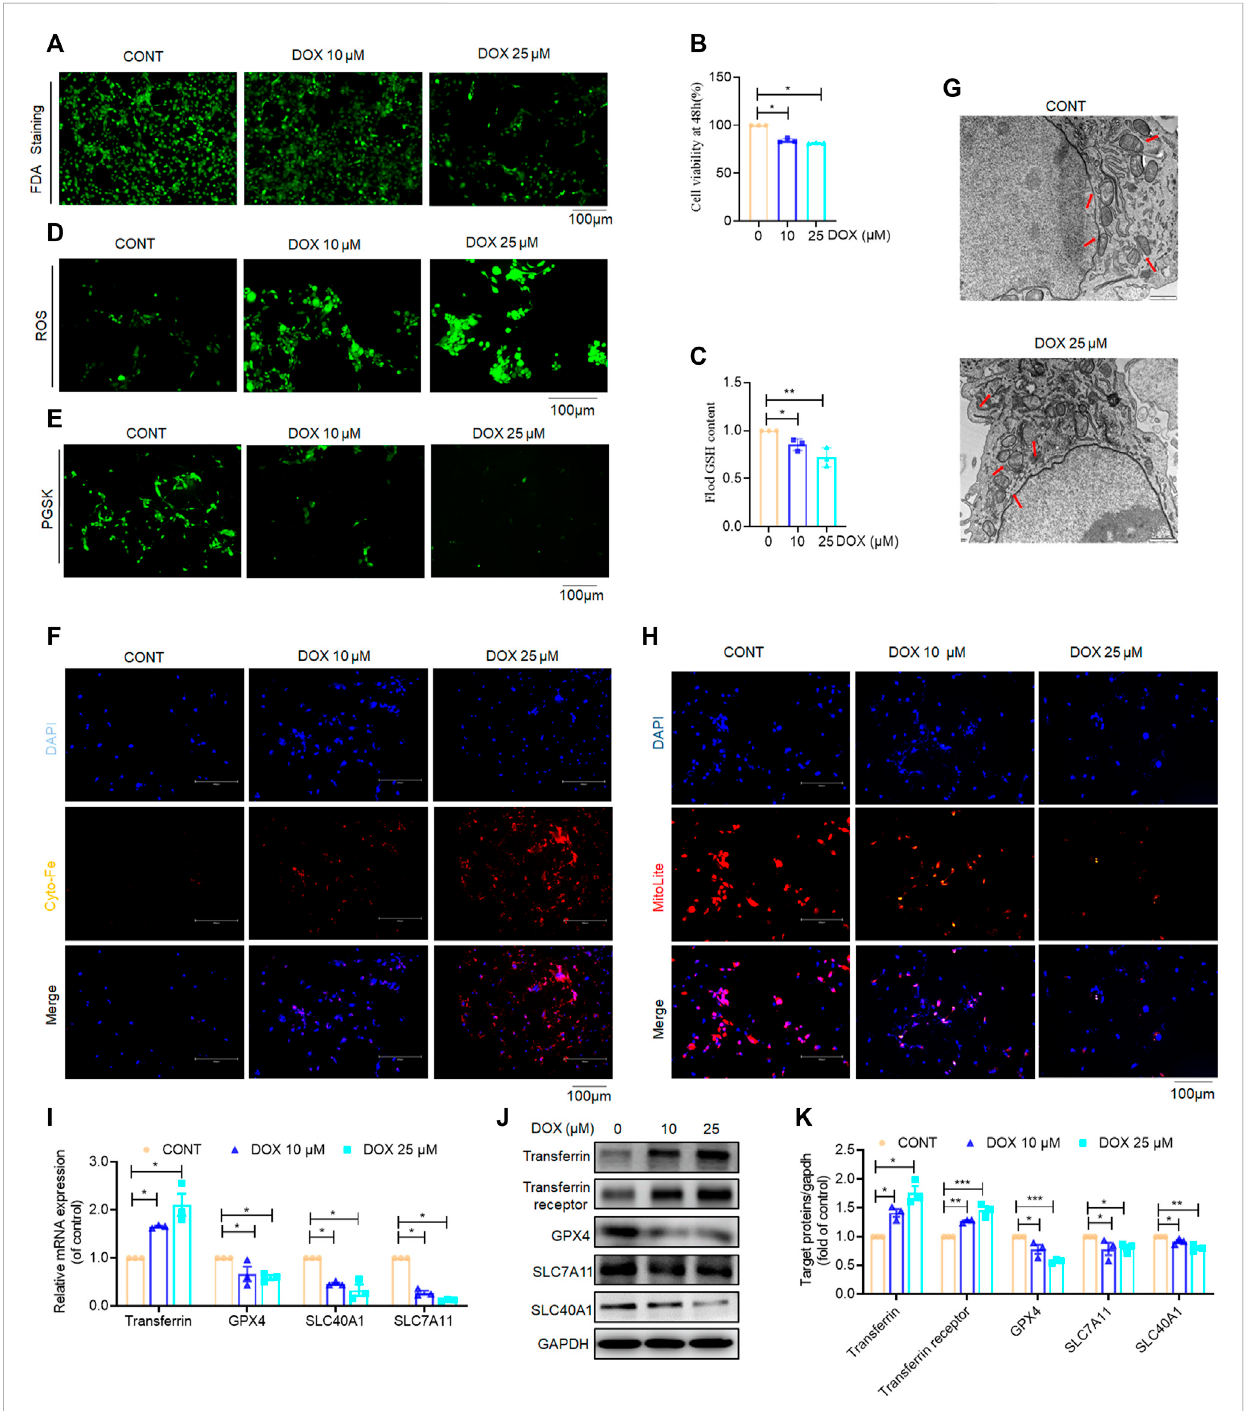
Effects of DOX triggers activated HSC ferroptosis in vitro . LX-2 was treated with DOX (10, 25 μ M) for 48 h (A) FDA staining for evaluating cell death. LX-2 was stained in 10 μ M FDA and the samples were observed with a fl uorescence inverted microscope. (B) Cell Count Kit-8 analysis of cell viability in LX-2. CCK-8 was incubated with LX-2 at 37 ° C for 1 h and the samples was measured using a multifunctional enzyme labeler at 405 nm. (C) Cellular GSH amount ( n = 3). (D) The ROS level in LX-2. LX-2 was stained in 10 μ M DCFH-DA in DMEM for 1 h at 37 ° C and the samples were observed with a fl uorescenceinvertedmicroscope. (E) FreeironlevelsinLX-2weremeasuredbyPhenGreenSKprobe.LX-2cellswerestainedin10 μ MPhenGreenSKin PBS for 1 h at 37 ° C and the samples were imaged immediately. (F) Representative fl uorescent images of intracellular iron level were identi fi ed by using FerroOrange (orange). Nuclei are stained by DAPI (blue). LX-2 was stained in 1 mM Ferro orange in PBS for 1 h at 37 ° C and constructs were imaged immediately. All samples as described (E,F) wereobserved with a fl uorescence inverted microscope. (G) The mitochondriamorphology was observed by transmission electronmicroscopyandmitochondriallengthwassummarized. (H) Mitochondrionstainingdetection.LX-2cellswerestained inthebuffer containinga1:500dilution ofMitoliteTM RedFX600 for1 hat37 ° Candthesampleswereobserved witha fl uorescence invertedmicroscope. (I) LX-2cell transferrin, GPX-4, SLC7A11, SLC40A1 mRNA expression ( n = 3). (J) The expression of LX-2 cell transferrin, transferrin receptor, GPX-4, SLC7A11,